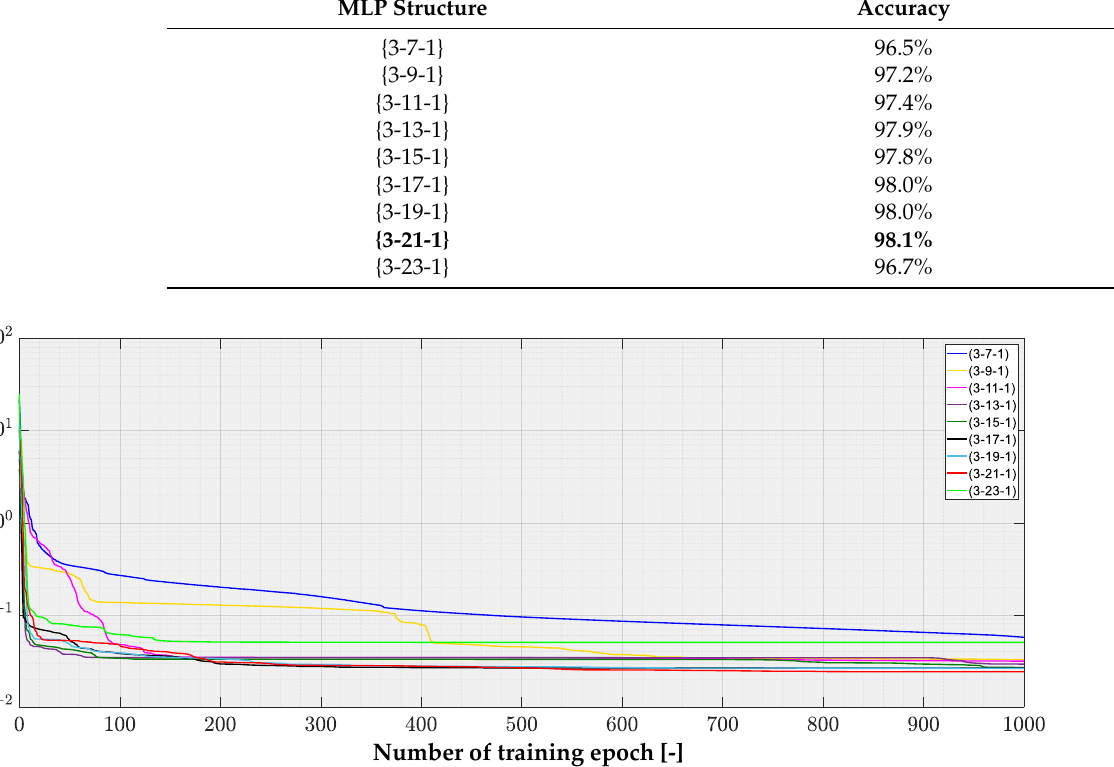
Figure 14. Loss (MSE) function during the training process of the MLP models with different struc- tures.